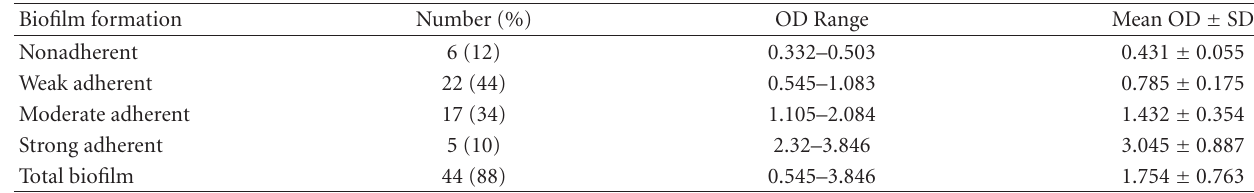
Table 1: Biofilm formation by Listeria ivanovii isolates ( n = 50) following incubation at 25 ◦ C.